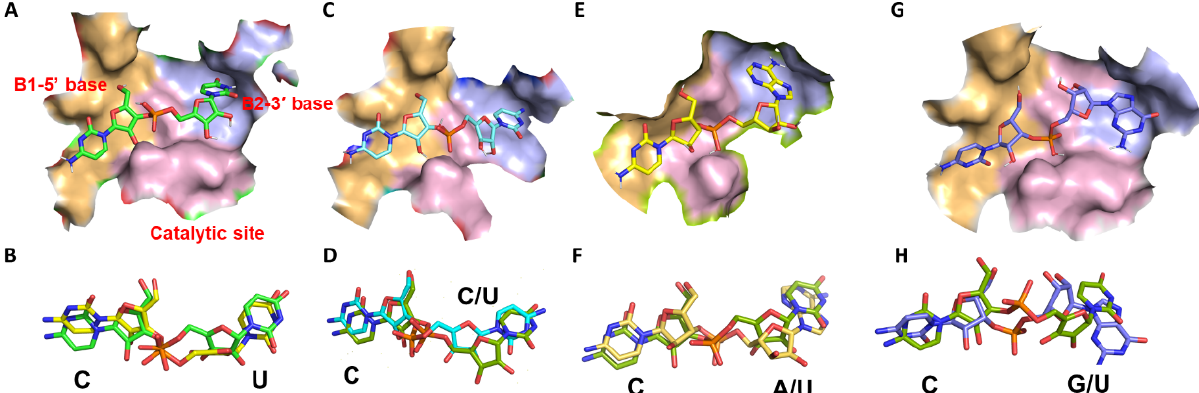
Figure 4. Surface view of the active site of cusativin homology model structure bound with dinu- cleotide ligands. ( A ) Cusativin docked with CpU, ( B ) Overlay of the CpU (green) docked to cusativin and the CpU docked to the MC1 (yellow) ( C ) Cusativin docked with CpC, ( D ) Overlay of the docked CpC (cyan) and CpU (green) bound to cusativin, ( E ) Cusativin docked with CpA dinucleotide, ( F ) Overlay of docked CpA (yellow) and CpU (green), ( G ) Cusativin docked with CpG (blue), ( H ) Overlay of docked CpG (blue) and CpU (green).